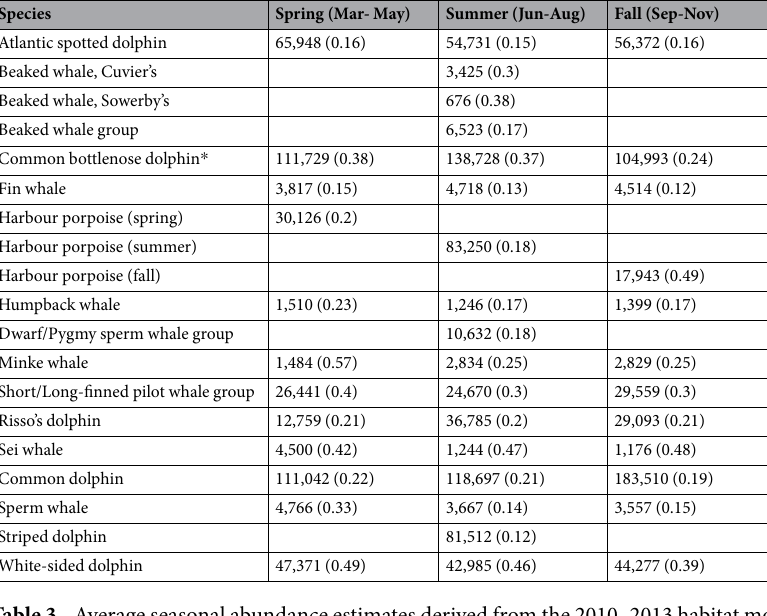
Table 3. Average seasonal abundance estimates derived from the 2010–2013 habitat models with its associated coefficient of variation in parenthesis. These estimates were previously reported in Palka et al . 14 .